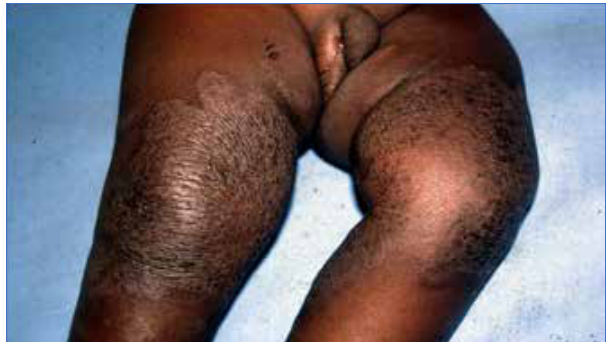
Figure 6: Atopic dermatitis on extensor aspect of